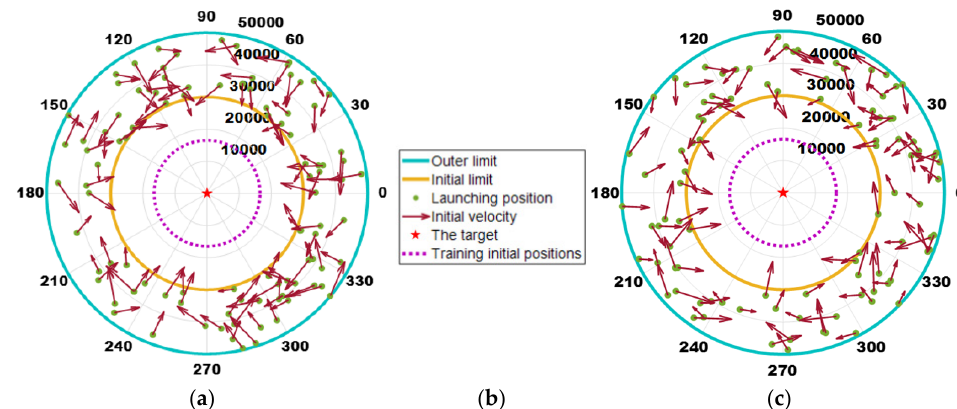
Figure 10. ( a ) Simulation dataset; ( b ) Legends; ( c ) utility evaluation dataset. The flow chart for overview of this study is shown in Figure 11.